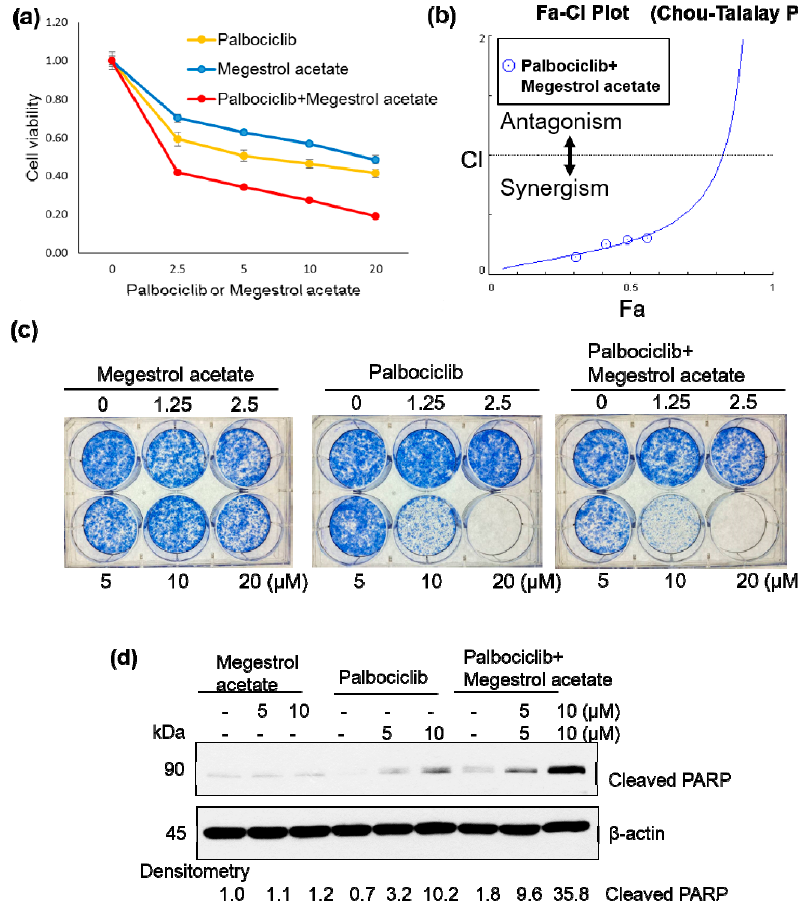
Figure 2. Figure 2. Cont.